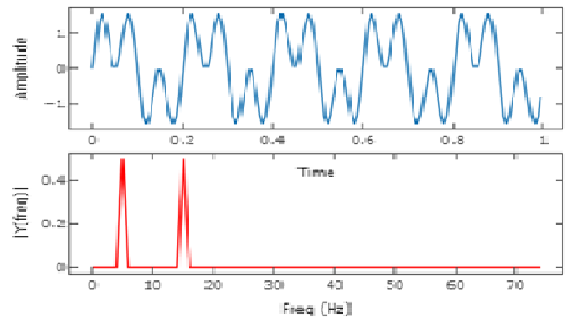
Fig. 1. Fourier Transform .